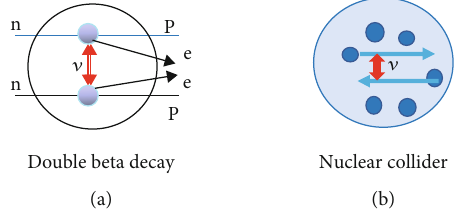
Figure 1: Schematic views of neutrinoless double β -decay with Majorana neutrino exchange (a) and nuclear collider